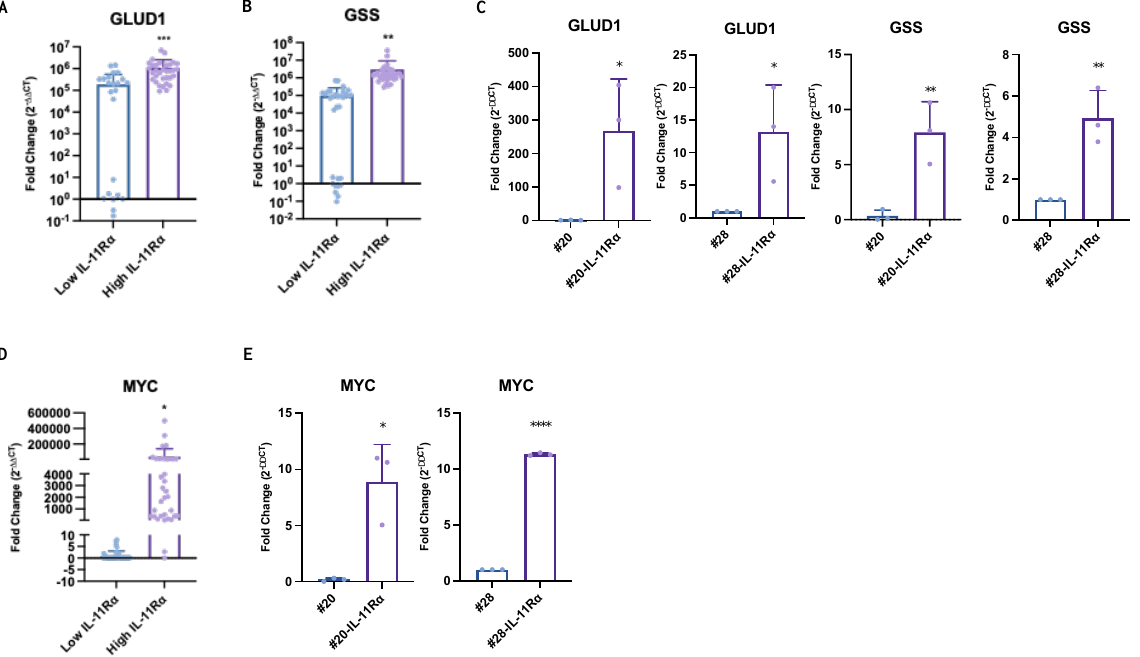
Figure 5. IL- 11Rα expression correlates with glutamine – glutamate-related genes in glioblastoma patient samples. Co-expression analysis of IL- 11Rα with ( A ) GLUD1 and ( B ) GSS gene expression was performed in glioblastoma patient samples using q-RT-PCR (n = 72, mean ± SD, where ** in- dicates p < 0.01 and *** indicates p < 0.001). Expression analysis of ( C ) GLUD1 and GSS gene ex- pression was performed in #20-IL- 11Rα and #28 -IL- 11Rα cells using q-RT-PCR (n = 3, mean ± SD, where * indicates p < 0.05 and ** indicates p < 0.01). Co-expression analysis of IL- 11Rα with ( D ) c-MYC gene expression was performed in glioblastoma patient samples using q-RT-PCR (n = 72, mean ± SD, where * indicates p < 0.05). Expression analysis of ( E ) c-MYC gene expression was per- formed in #20-IL- 11Rα and #28 -IL- 11Rα cells using q-RT-PCR (n = 3, mean ± SD, where * indicates p < 0.05 and **** indicates p < 0.0001).